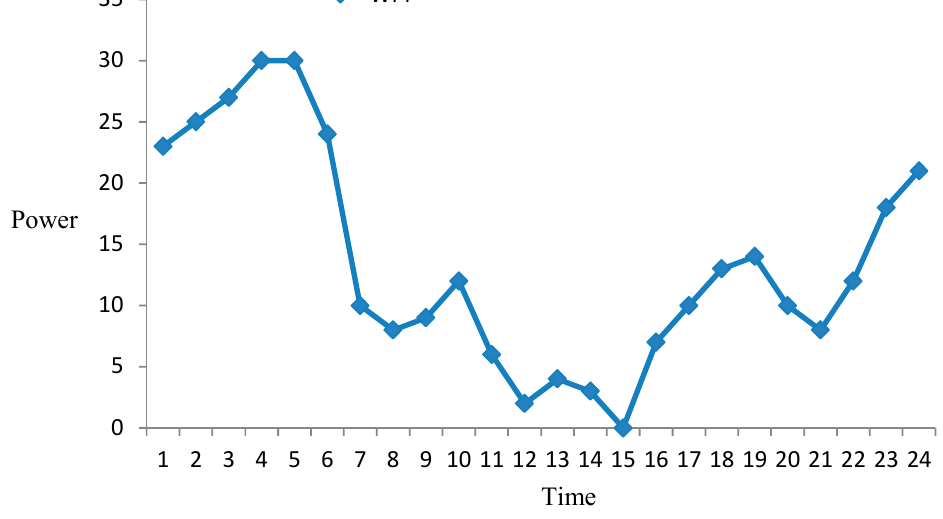
Figure 3. Wind turbine power output curve.